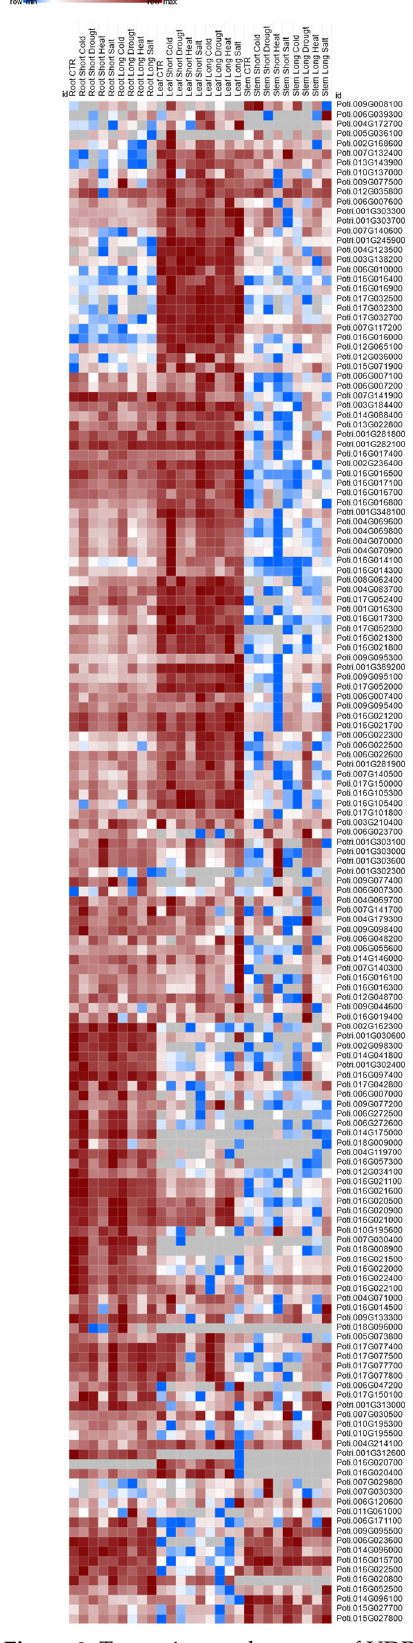
Figure 8. Transcriptome heatmap of UDP glycosyltransferases (UGTs) under different abiotic stress conditions.